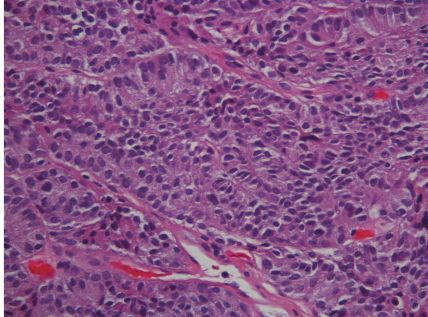
Figure 3: High magnification image showing well-differentiated cells forming tubular and glandular structure without atypia.